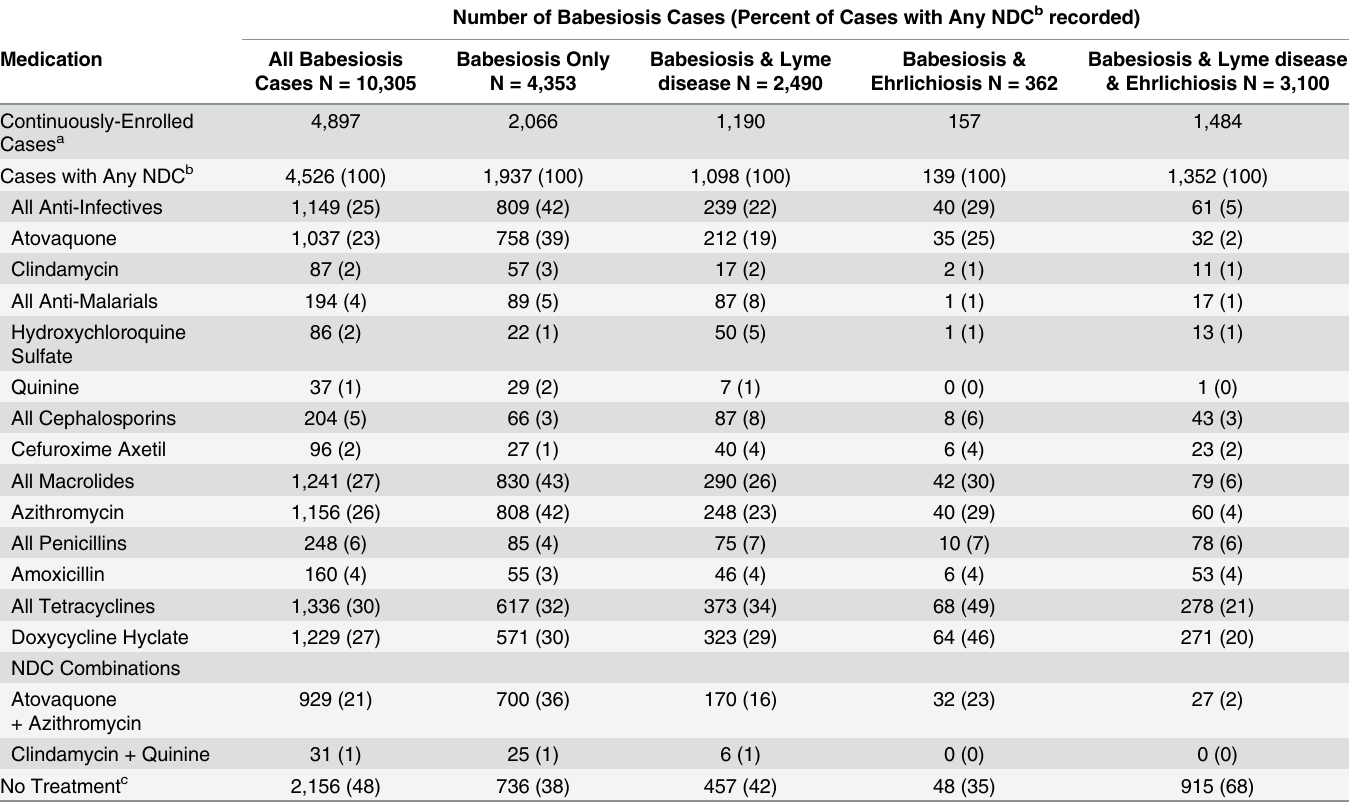
Table 3. Medication Use in the 7 Days following Babesiosis Diagnosis, Overall and in the Four Babesiosis Groups. Number of Babesiosis Cases (Percent of Cases with Any NDC b